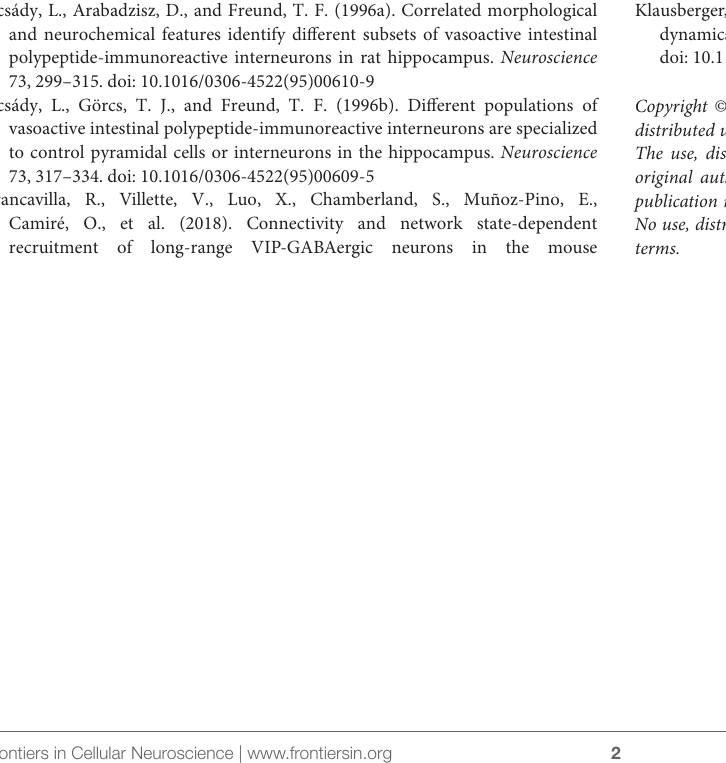
including bistratified cells and oriens–oriens INs, have been described and recently a new VIP expressing interneuron population located at the O/A ( VIP + long-range projecting INs, VIP + LRP INs ) was described targeting INs within the O/A in CA1 but also both INs and pyramidal cells within the